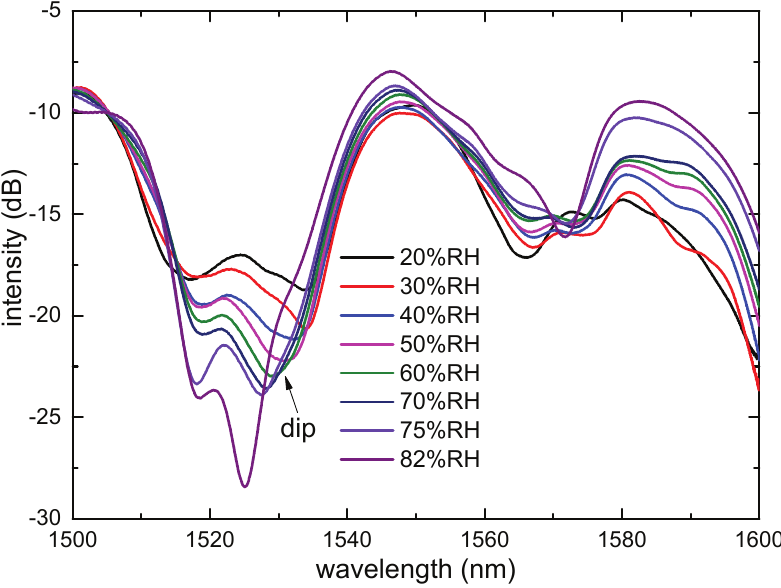
Figure 6. Transmission spectra at different RH values of the sensor coated by 0.1 wt/vol % agarose